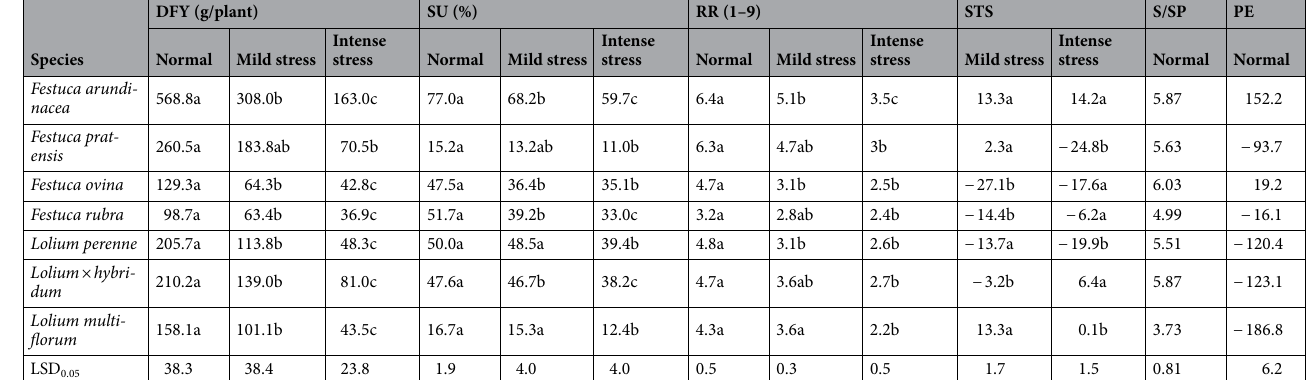
Table 1. Means of measured traits in seven grass species under three irrigation treatments (normal, mild and intense drought stress). DFY dry forage yield, SU survival, RR recovery rate, STS stress tolerance score, S/ SP summer dormancy, PE persistence. In each row (among three irrigation environments) means followed by a common letter are not significantly different according to the LSD test at an alpha level of 0.05. In each column, If the difference between the means is greater than the LSD 0.05 , then the means (among species) are significantly